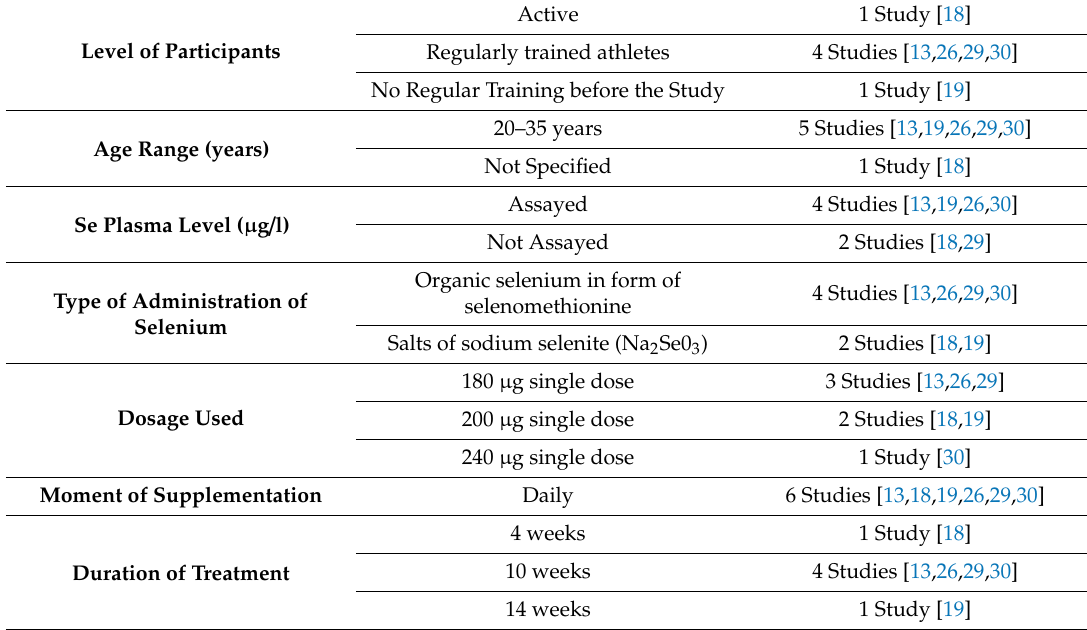
Table 1. Characteristics of participants and interventions in the studies included in the